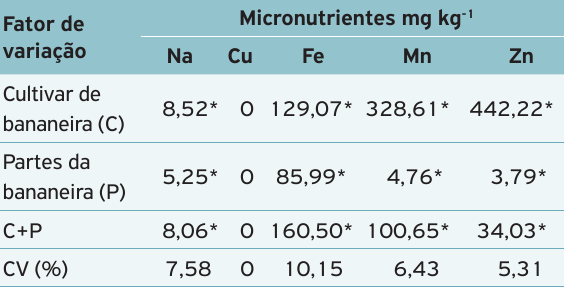
Tabela 2. Valores F obtidos na análise de variância de micronutrientes nos subtratos residuais à base de resíduos